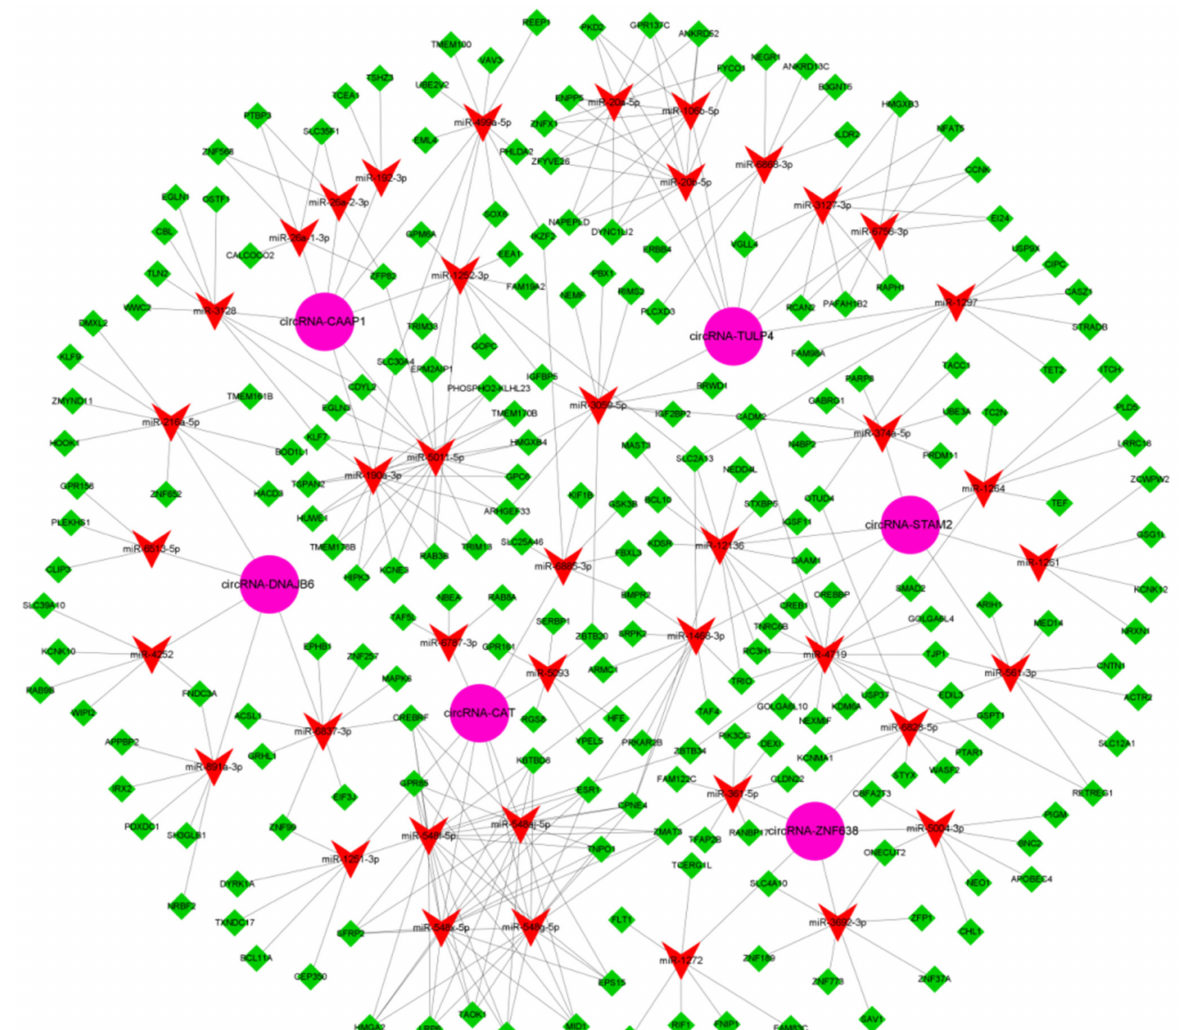
Figure 5. Integrated ceRNA network of the six putative m 6 A-circRNAs with higher expression in skin tissue at anagen of cashmere goats in comparison to telogen. The pink circle, red “V”, and green diamond shapes represent m 6 A-circRNAs, miRNAs and target genes, respectively. circRNA-ZNF638 = m 6 A-circRNA-ZNF638, circRNA-DNAJB6 = m 6 A-circRNA-DNAJB6, circRNA-TULP4 = m 6 A- circRNA-TULP4, circRNA-CAT = m 6 A-circRNA-CAT, circRNA-CAAP1 = m 6 A-circRNA-CAAP1, circRNA-STAM2 = m 6 A-STAM2. This integrated ceRNA network was constructed and visualized using the Cyotoscape (Version 2.8) procedure